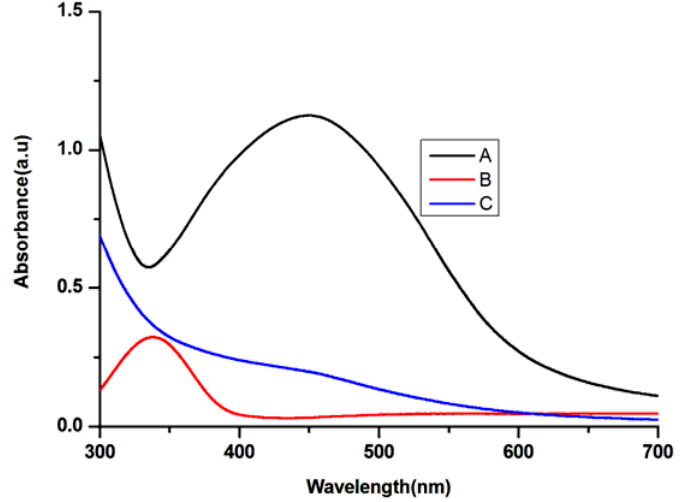
solution; Curve C corresponds 3 solution. 3